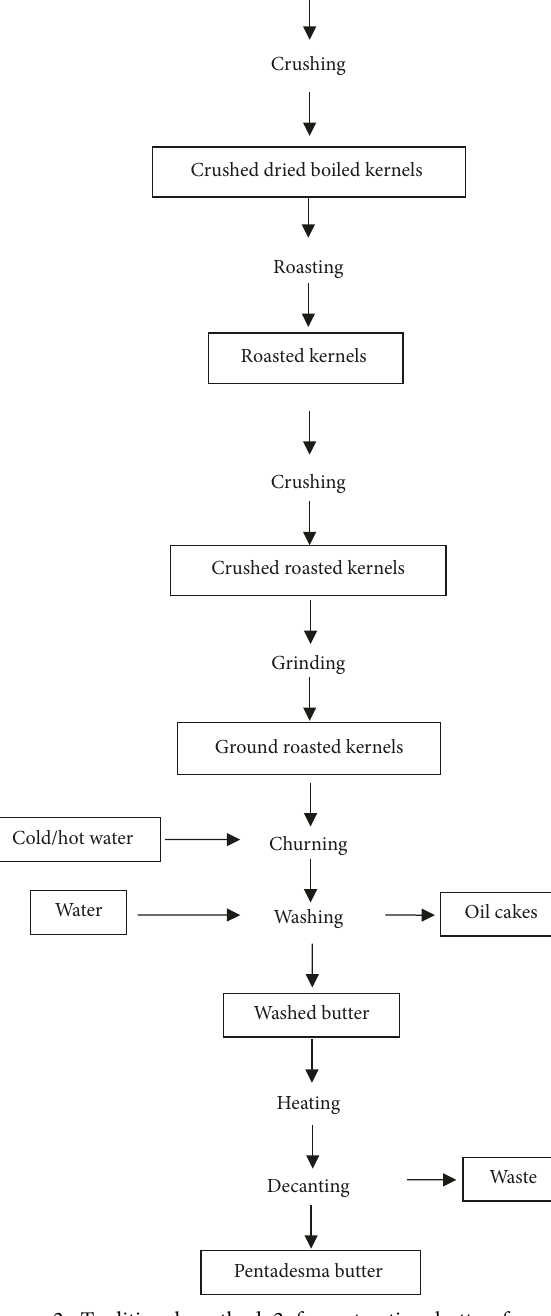
Figure 2: Traditional method 2 for extracting butter from P . butyracea